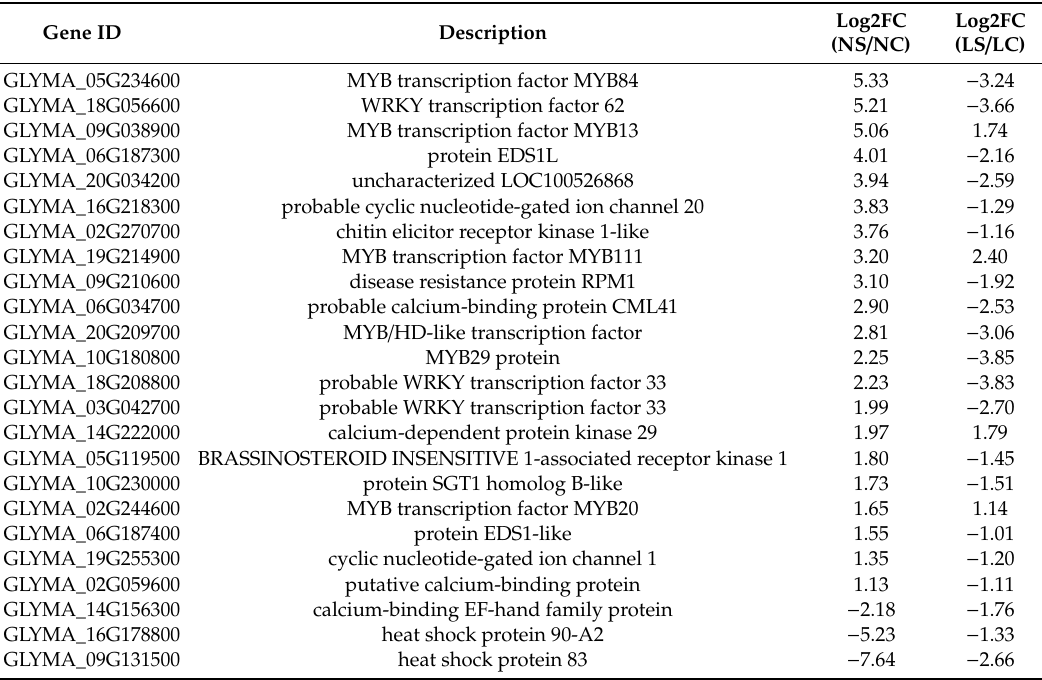
Table 1. Overlapped DEGs related to plant-pathogen interactions under two light